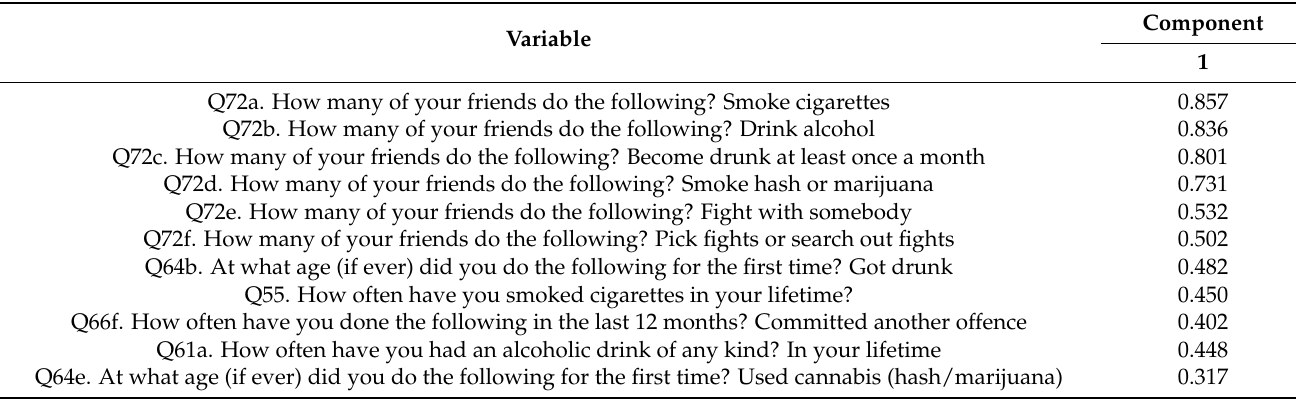
Figure 1. Scree plot indicating eigenvalues of components in PCA. Table 1. Rotated Component Matrix indicating variable loadings for AOD use susceptibility, the component *.